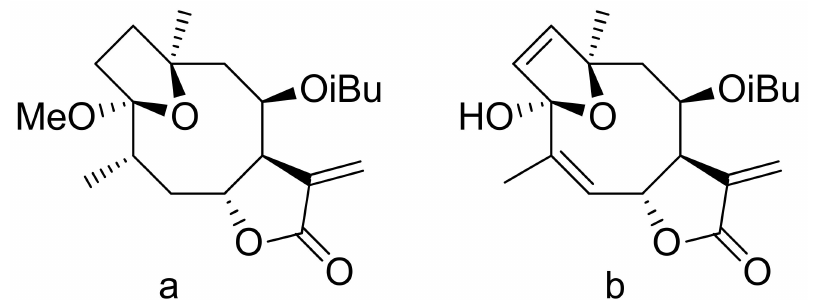
Figure 22. Antileishmanicidal lactones from Tithonia diversifolia ( a , b ) Otoguro and his group proved antitrypanosomal activity against Trypanosoma brucei of sesquiterpenoid lactones. The best result was obtained by 4-peroxy-1,2,4,5-tetrahydro- ± 0.02 µ g/mL [98]. Enzyme inhibition is a α -santonin with the EC 50 value 0.40